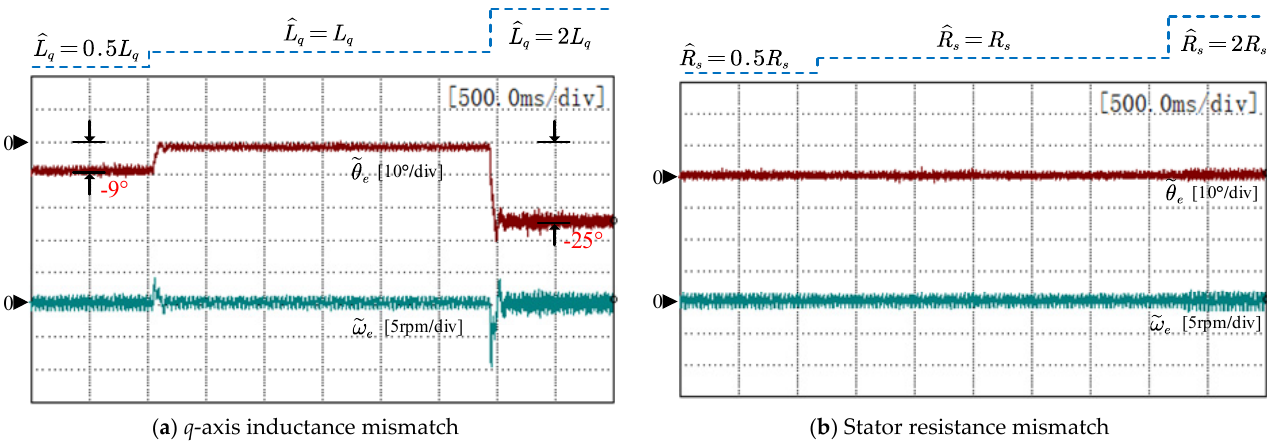
Figure 18. Experimental results of the position estimation error and the speed estimation error at 300 rpm with mismatched parameters (enhanced LESO-based QPLL).